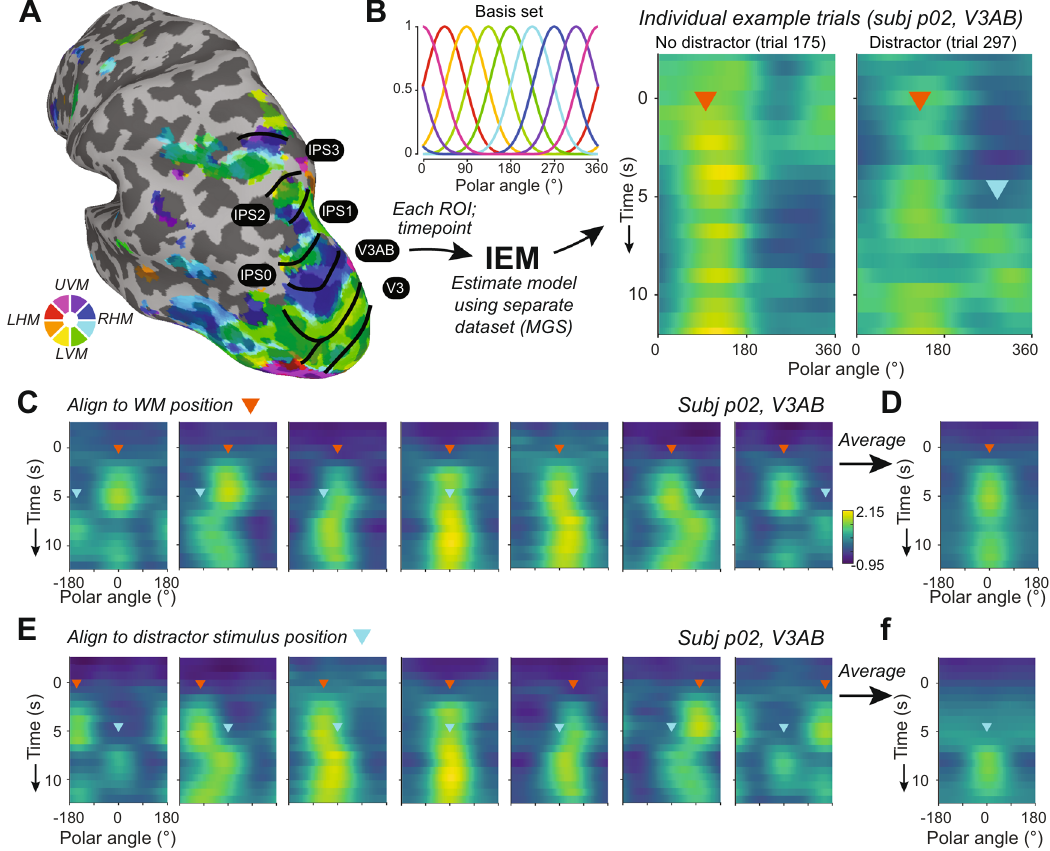
Fig. 3 IEM-based reconstruction of WM and distractor representations. A Each participant underwent retinotopic mapping to de fi ne ROIs in visual, parietal, and frontal cortex (V1 – V3, V3AB, hV4, LO1, IPS0-3, and sPCS). Example hemisphere and participant shown (p02, LH). Each voxel ’ s time course is fi t with a receptive fi eld model 36 . Color depicts preferred polar angle; thresholded at R 2 ≥ 10%. B We estimated an inverted encoding model (IEM) for polar angle for each participant and ROI using a dataset reserved for this purpose (single-item memory-guided saccade task, 3 – 4.5 h/participant). Because we used a fi xed encoding model 41,42 , reconstructions across different timepoints and task conditions can be directly compared to one another. Each timepoint of the spatial distractor dataset was reconstructed using this independently estimated model, and each row shows a reconstruction over polar angles computed as the sum of basis functions weighted by the corresponding reconstructed channel response (see refs. 10,43 . Two example trials shown, and trials are not aligned to a common position. C In the example participant, reconstructions were aligned based on WM target positions (orange triangle), and separately averaged for each distractor bin position (cyan triangle at onset time). Note that both target and distractor representations can be seen in the reconstructions. D WM target reconstruction averaged over all distractor location bins. Because distractors are evenly presented around the screen with respect to WM locations (Fig. 1a), averaging across relative distractor positions reveals target-related spatial representations because distractor representations are washed out during the averaging procedure. E The same data as ( C , D ) now aligned to each trial ’ s distractor position (cyan triangles), and averaged separately for each relative distractor location bin (WM targets are at different locations relative to distractor; orange triangles). F Distractor location reconstruction averaged over all relative WM target location distractor locations (Fig. 3C, D). Similarly, to visualize the representations of the visual distractor, we aligned the same data based on the distractor location, which averages over all relative target locations (Fig. 3E, F, as in Rademaker et al. 22 . Importantly, because distractors were presented with equal likelihood at one of seven location bins relative to the WM target (Fig. 1A), we were able to independently visualize and assay WM representations and distractor representations on distractor-present trials.